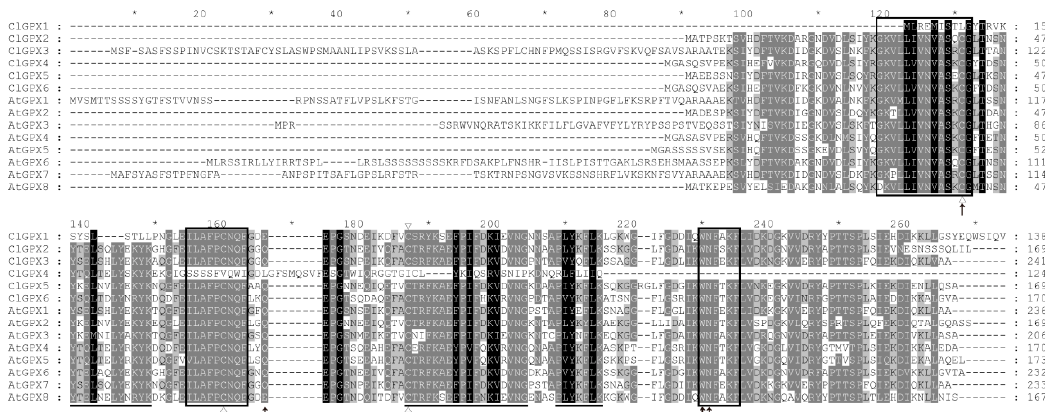
Figure 1. Multiple sequence alignment of GPX protein sequences from watermelon and Arabidopsis . Sequence alignments were obtained using Clustal Omega. The three boxes indicate the GPX signature motifs 1, 2, and WNFXKF. Three other conserved domains are underlined. Three conserved Cys residues replaced by Sec in mammalian GPXs are marked by triangles. Arrows represent the conserved amino acid residues (Cys, Gln, Trp, and Asn) involved in the potential catalytic sites.